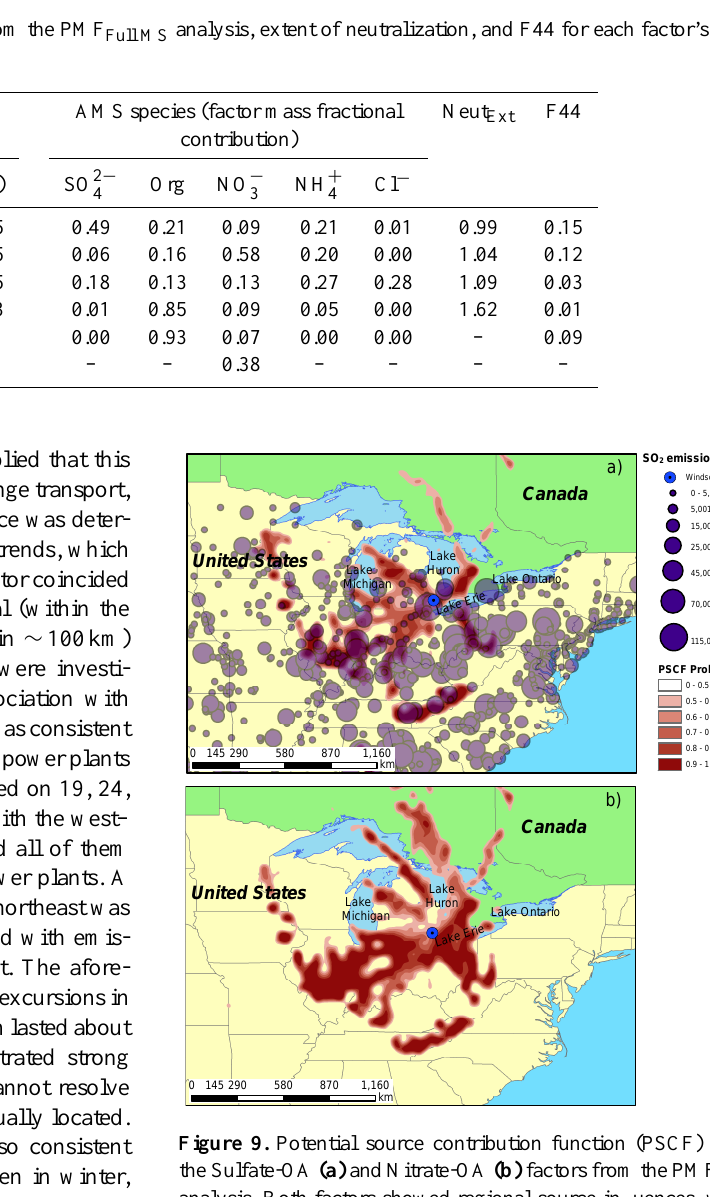
et al., 2011), and the nearby rural location of Harrow,